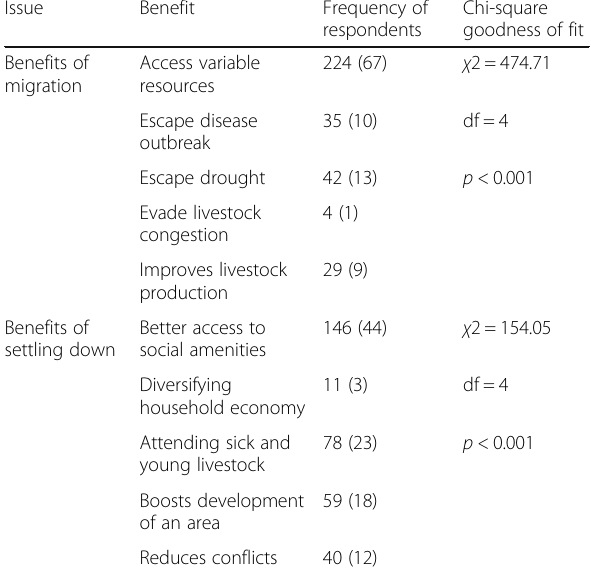
Table 3 Importance of migration and sedentarization as perceived by the community